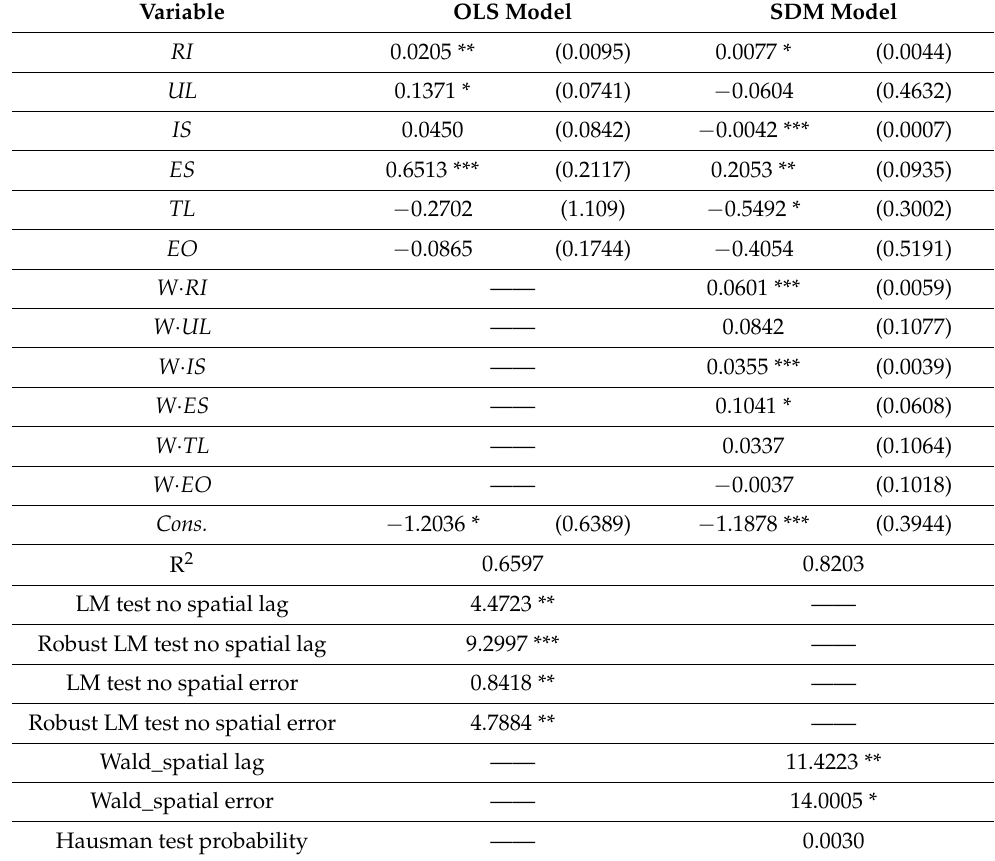
Table 3. OLS and SDM regression